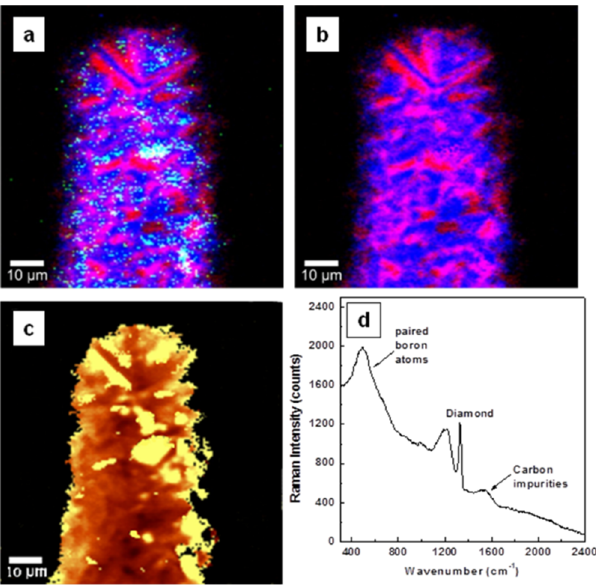
Figure 3. Surface confocal Raman images of heavily doped diamond film mapping the spatial distribution of: ( a ) diamond (red), boron incorporation (blue), and sp 2 carbon impurities (green), ( b ) diamond (red) and boron incorporation (blue), and ( c ) induced stress. Yellow pseudo-color in the stress image corresponds to higher induced stress. White, magenta, and turquoise colors observed in images ( a ) and ( b ) are due to combinations of red with blue and green, of red with blue, and of blue with green, respectively. ( d ) Integrated Raman spectrum of image ( a